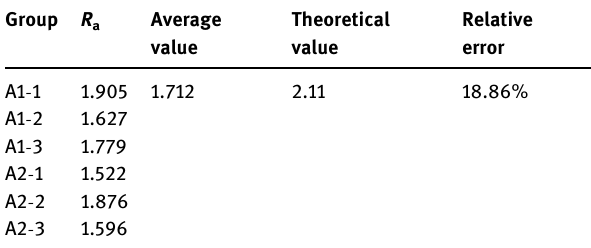
Table 4: The comparison and analysis of the measured and simu - lation residual stress ( unit: MPa )